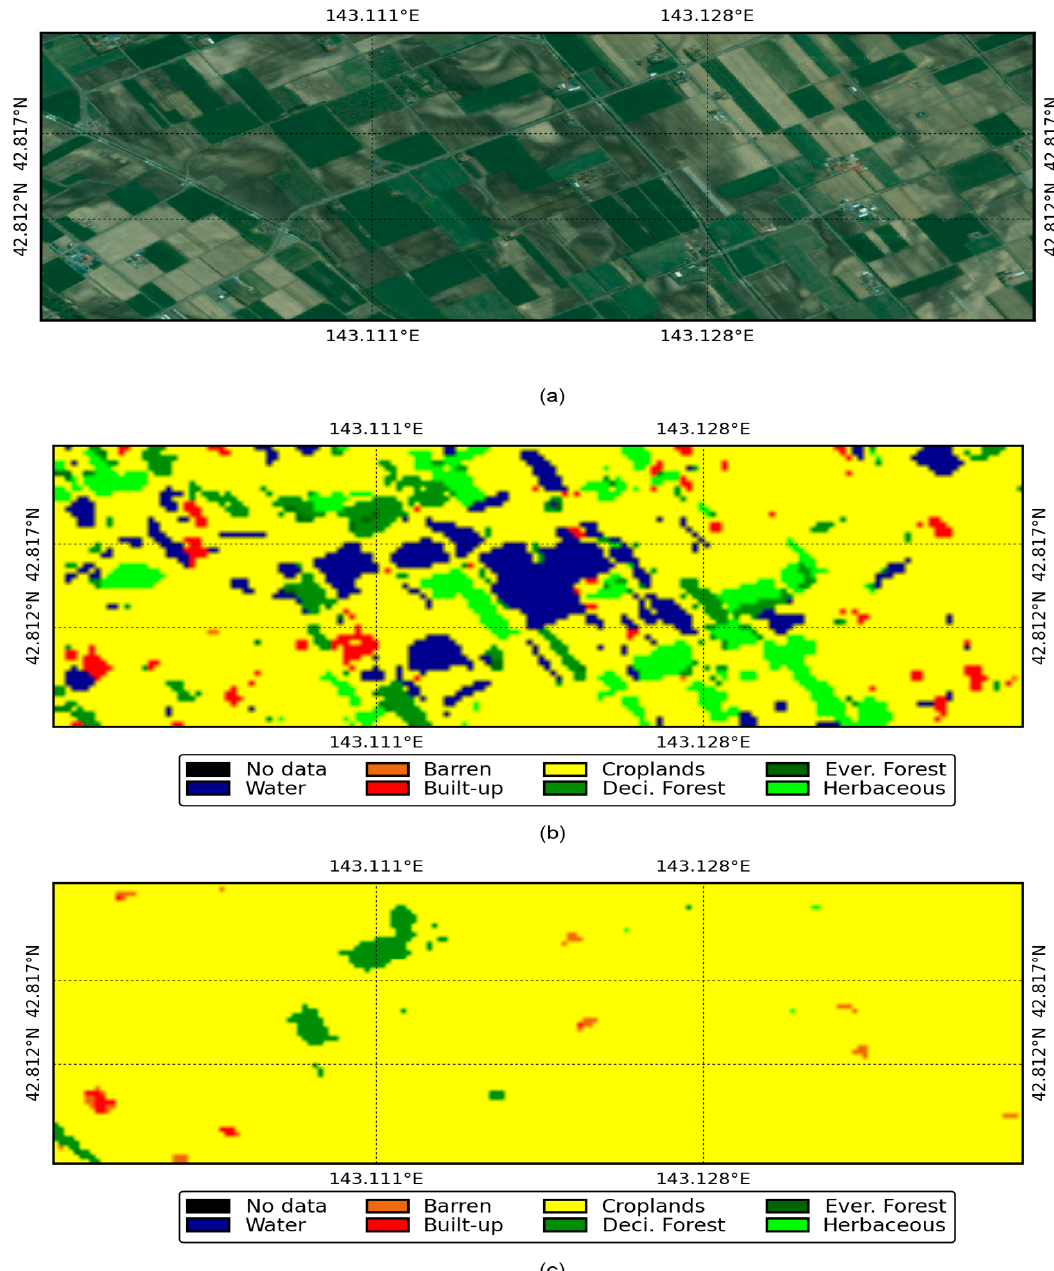
Figure 9. Performance of the JpLC-30 map over the JHR LULC map: ( a ) Google Earth™ image; ( b ) JHR LULC map; ( c ) JpLC-30 map.